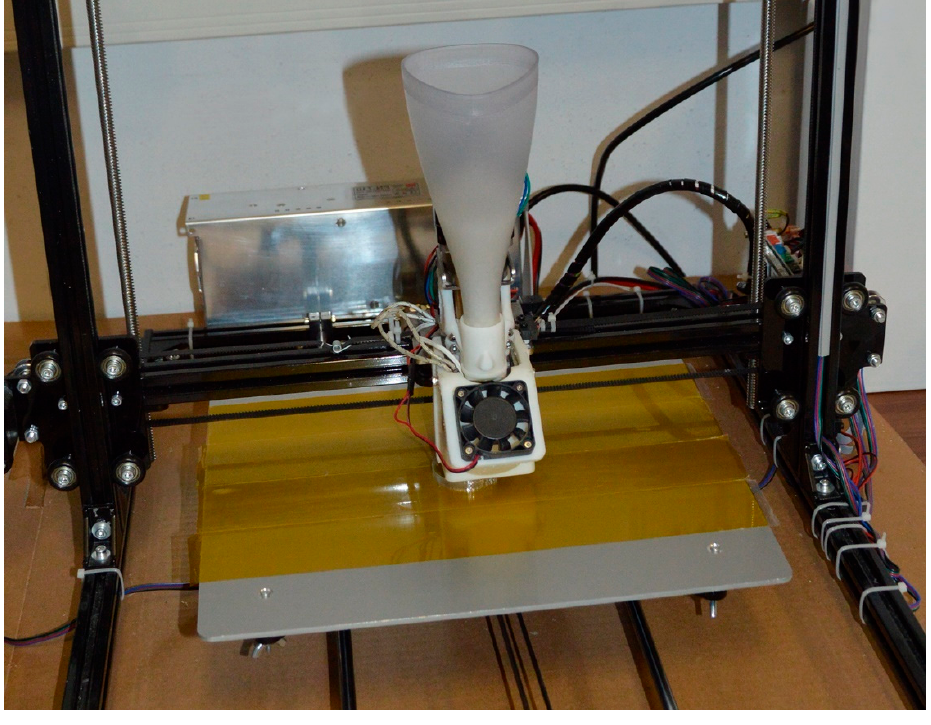
Figure 2. Photo of the customized FGF 3D printer with Mahor extruder. Table 1. Printing parameters established on Slic3r